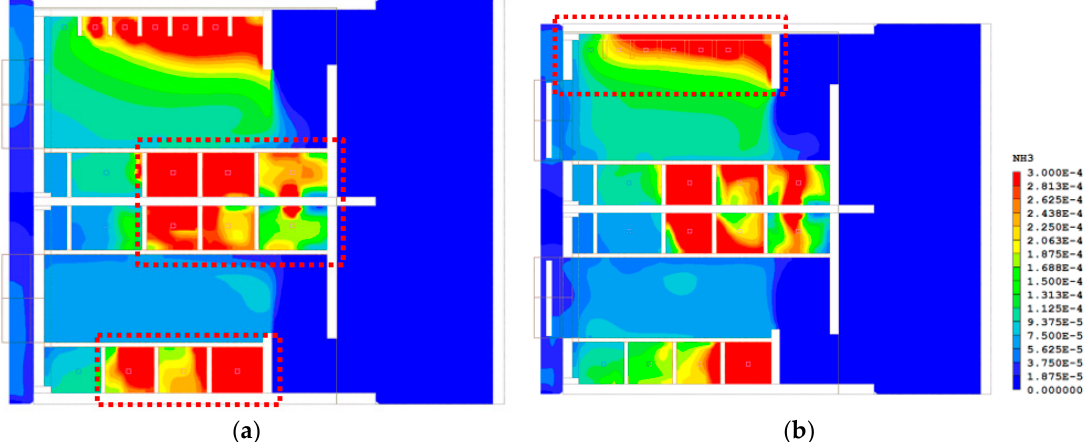
Figure 8. NH 3 concentration (PPMV) distributions at heights of squatter and standee breathing zones for south wind (window configuration: W2; the opening angle θ is 45°; the outdoor wind speed is 1 m/s). ( a ) Height Z = 0.6 m (height of the squatter’s breathing zone). ( b ) Height Z = 1.5 m (height of the standee’s breathing zone).